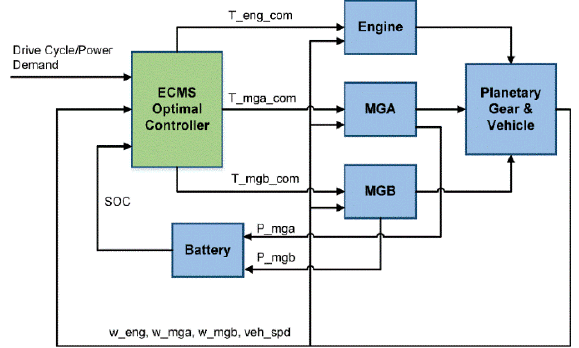
Figure 9. Simulation framework with an ECMS optimal controller for alternative powertrain configurations. The equivalent fuel consumption, which is the objective function of ECMS, is: . m